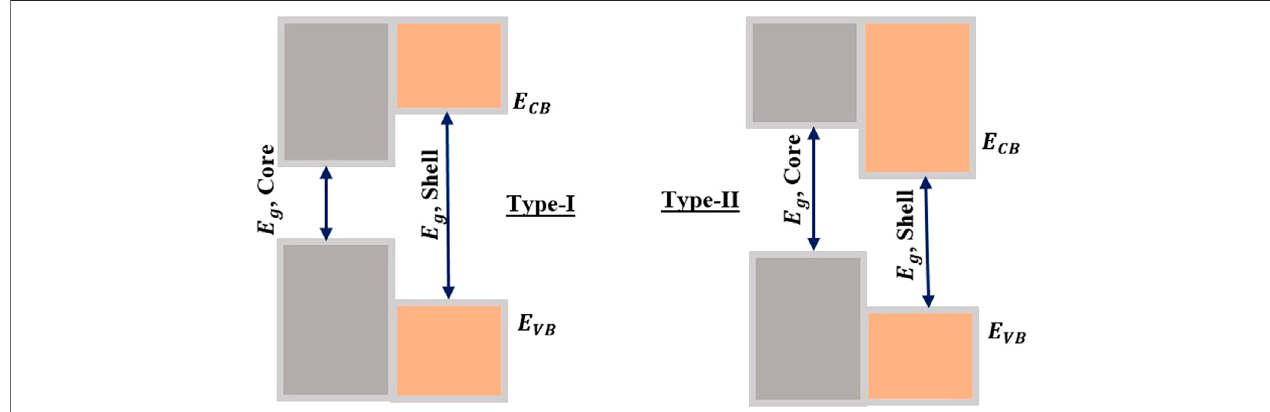
FIGURE 7 | Representation of the Type-I and Type-II core-shell quantum dots based on the band alignment [77].